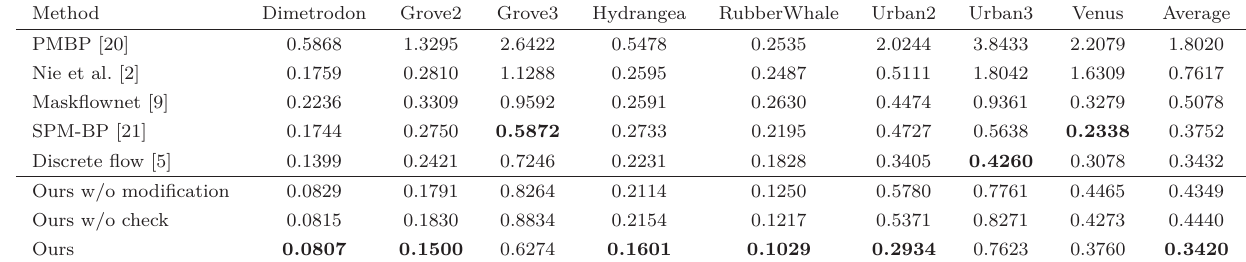
Table 2 Motion error (EPE) for the Middlebury benchmark